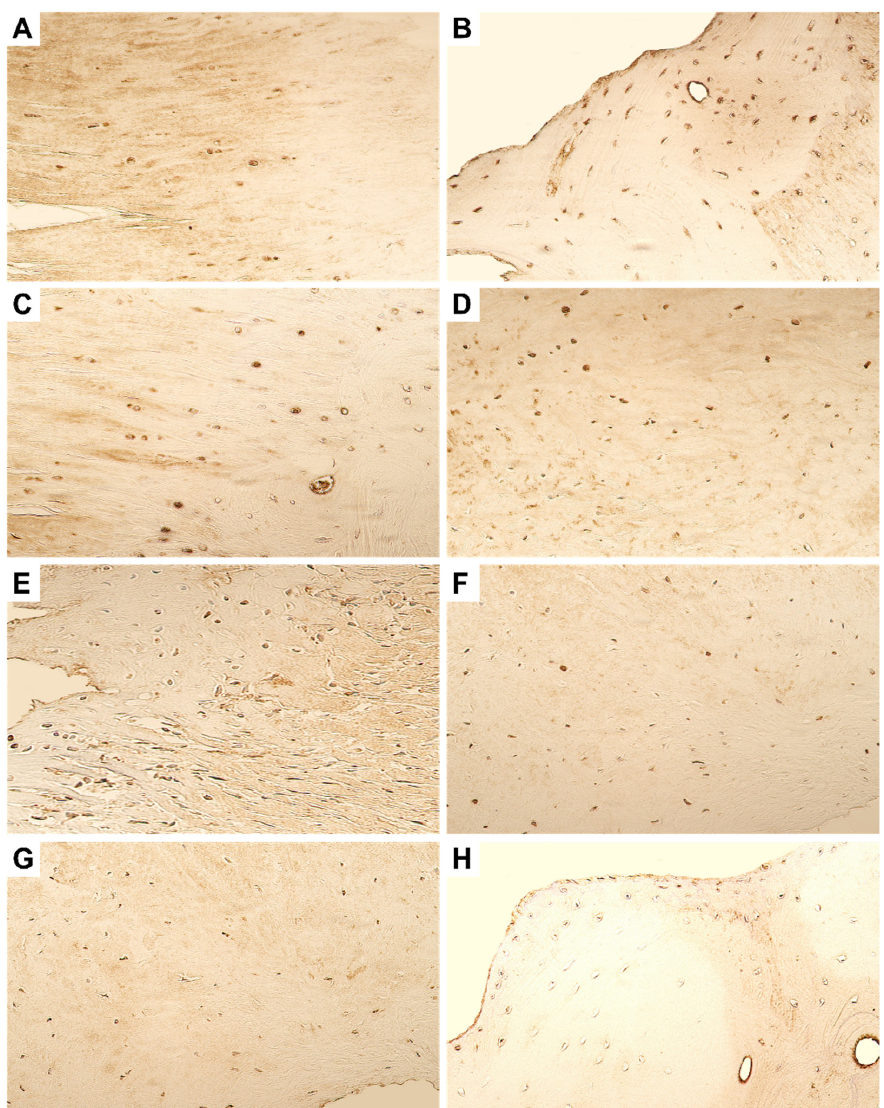
Figure 4. Microphotographs of the ankylotic bone and fibrous cartilage tissue immunostained for bFGF, FGFR-1, IL-1 α , and TNF- α . ( A ) Few bFGF-positive chondrocytes can be seen in the primary surgery tissue material. ( B ) Moderate bFGF-positive osteocytes can be noted in the repeated surgery tissue material. ( C ) Moderate FGFR-1-positive chondrocytes in the fibrous cartilage of the primary surgery tissue material can be seen. ( D ) In the repeated surgery material, moderate FRFR-1-positive cells can be visualized. ( E ) Moderate IL-1 α -positive cells can be seen in the primary surgery material. ( F ) Moderate IL-1 α -positive cells can also be noted in the repeated surgery material. ( G ) Numerous-positive TNF- α cells in the primary surgery tissue. ( H ) Note presence of few TNF- α -positive osteocytes in the repeated surgery material. Original magnification, 250×.